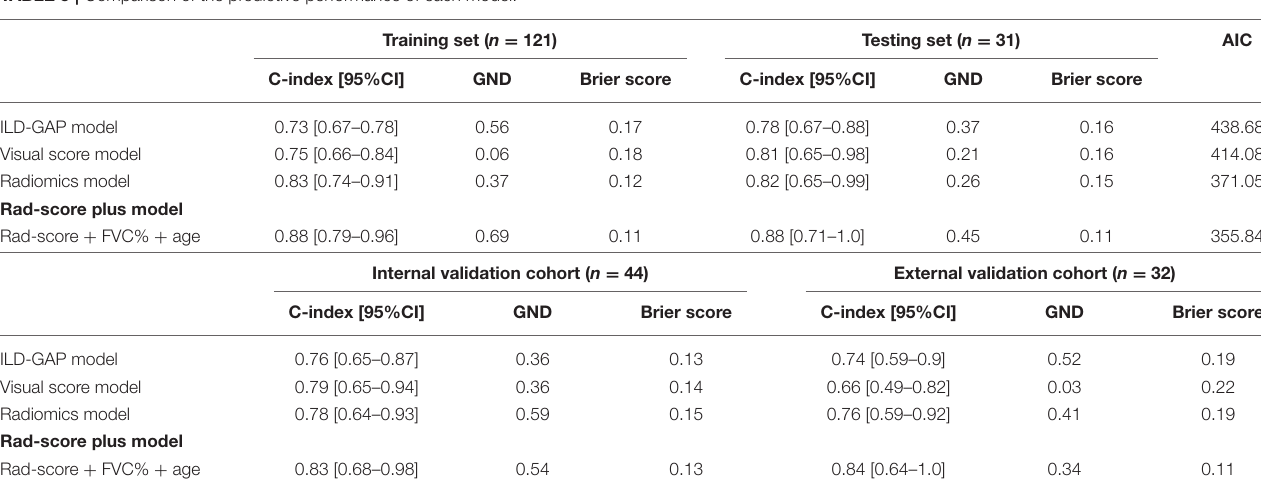
TABLE 5 | Comparison of the predictive performance of each